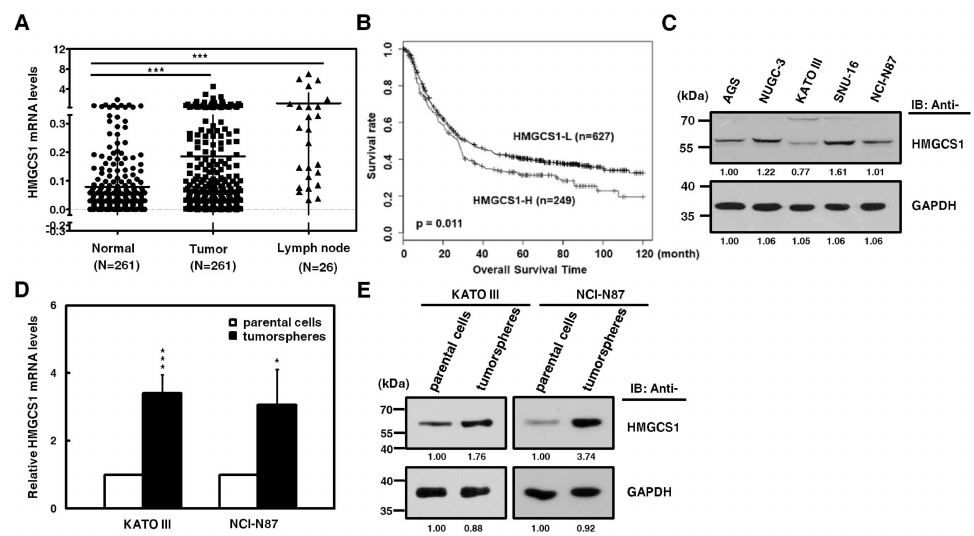
Figure 1. 3-hydroxy-3-methylglutaryl-CoA synthase 1 (HMGCS1) expression is upregulated in stomach adenocarcinoma samples of patients and tumorspheres of gastric cancer cells. ( A ) Levels of HMGCS1 mRNA in tumors, the adjacent nontumor tissues, and lymph node tumor sample pairs from gastric cancer patients (HMGCS1 in tumors and the adjacent nontumor tissues, n = 261; HMGCS1 in lymph node tumor samples, n = 26) were examined using quantitative real-time PCR analysis. HMGCS1 mRNA levels in the gastric cancer tissues or lymph node tumor samples were compared with those of the corresponding adjacent normal tissues. Mean ± SD. *** p < 0.001. ( B ) The Kaplan-Meier survival plot of gastric cancer patients with higher (HMGCS1-H, n = 249) or lower (HMGCS1-L, n = 627) levels of HMGCS1 mRNA. p = 0.011. ( C ) Whole-cell extracts of gastric cancer cells including AGS, NUGC-3, KATO III, SNU-16, and NCI-N87 cells were prepared for Western blot analysis using anti-HMGCS1 and anti-glyceraldehyde-3-phosphate dehydrogenase (GAPDH) antibodies. ( D, E ) KATO III and NCI-N87 cells were seeded onto ultra-low attachment plates under stem cell-selective conditions for the subsequent formation assay of tumorspheres. The transcript levels of HMGCS1 in parental cells and tumorspheres of KATO III and NCI-N87 cells were measured by quantitative real-time PCR and then normalized to GAPDH ( D ). Mean ± SD ( n = 3). * p < 0.05; *** p < 0.001. Whole-cell extracts of parental cells and tumorspheres of KATO III and NCI-N87 cells were prepared for Western blot